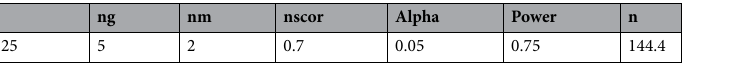
Table 1. Input and output for sample size planning for repeated-measures ANOVA. () n sample size, ng number of groups, nm number of measurements, f effect size (prior medium value = 0.25), nscor sphericity